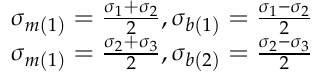
Figure 6. Model of cantilever beam and distribution of field nodes.